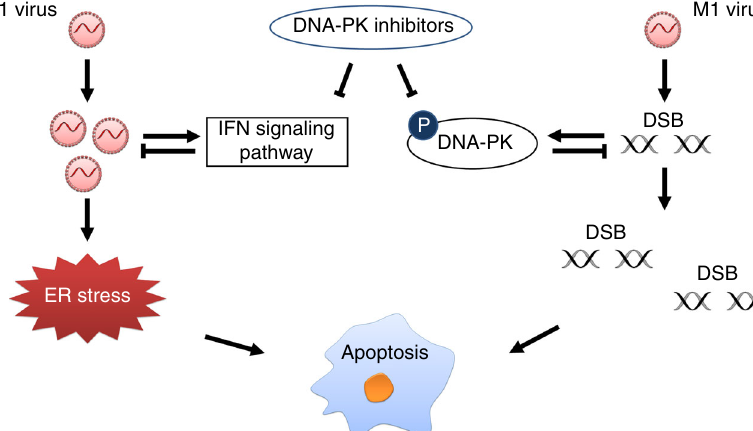
Fig. 8 Graphical model of DNA-PKI and OV M1 combination therapy. A subset of tumour cells are innately resistant to oncolytic virus M1, and infection induces the production of type I IFN, which hampers viral replication. Treatment with DNA-PK inhibitors blocks the IFN antiviral response induced by M1 virus, resulting in increased virus replication, and triggers prolonged and severe ER stress. In addition, M1 virus causes DNA damage in tumour cells. In response to DNA damage, DDR pathways are immediately activated by PI3K-related kinases, including DNA-PK, to maintain gene stability. Thus, co- treatment with DNA-PK inhibitors hinder the DNA repair function and promote DNA damage induced by M1 virus. Above all, the DNA-PK inhibitors